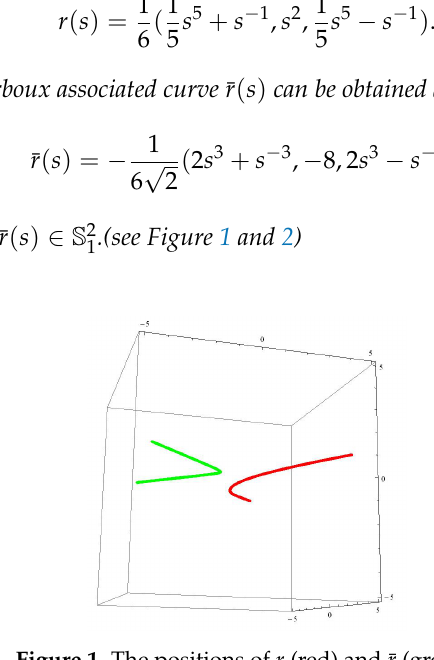
Figure 1. The positions of r (red) and ¯ r